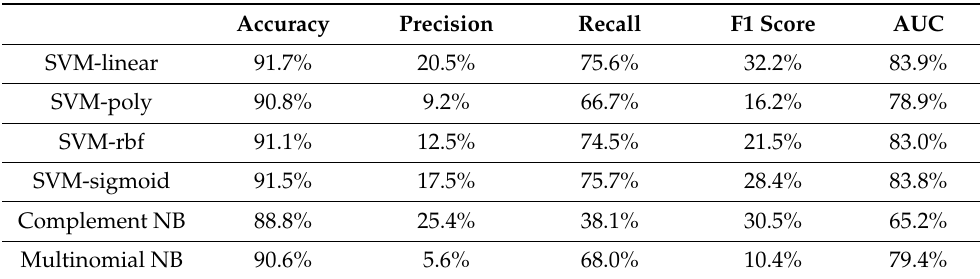
Table 3. Performance of the SVM and NB models on the development